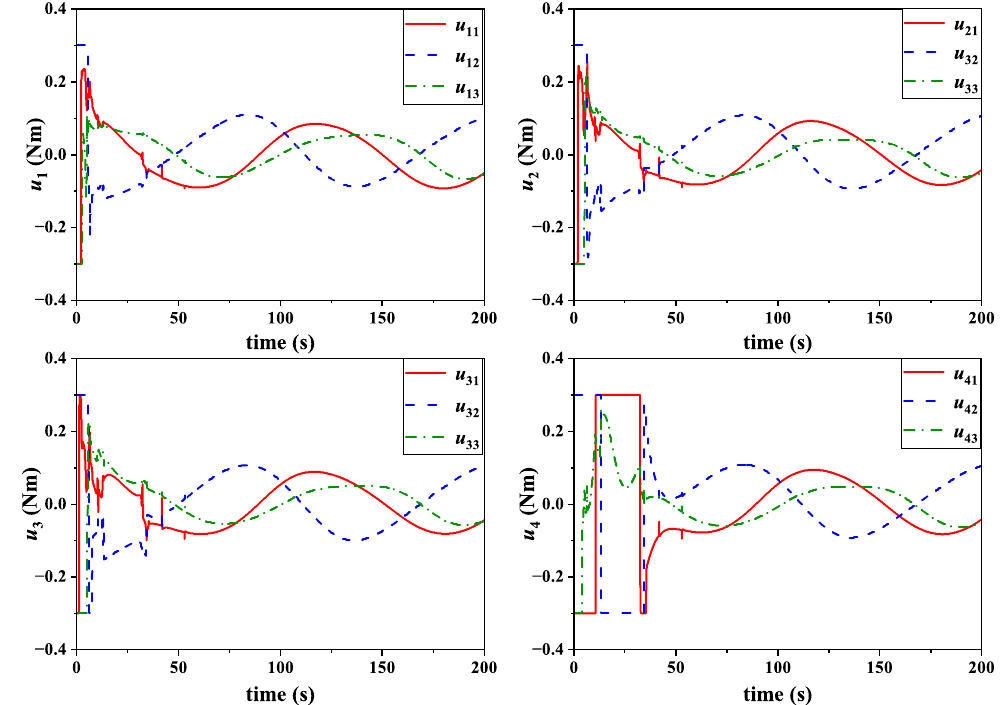
Figure 6. Control torques of four